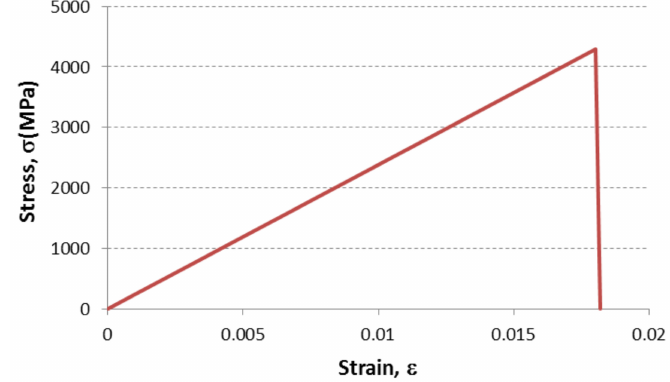
Figure 3. Stress-strain relationship for the CFRP